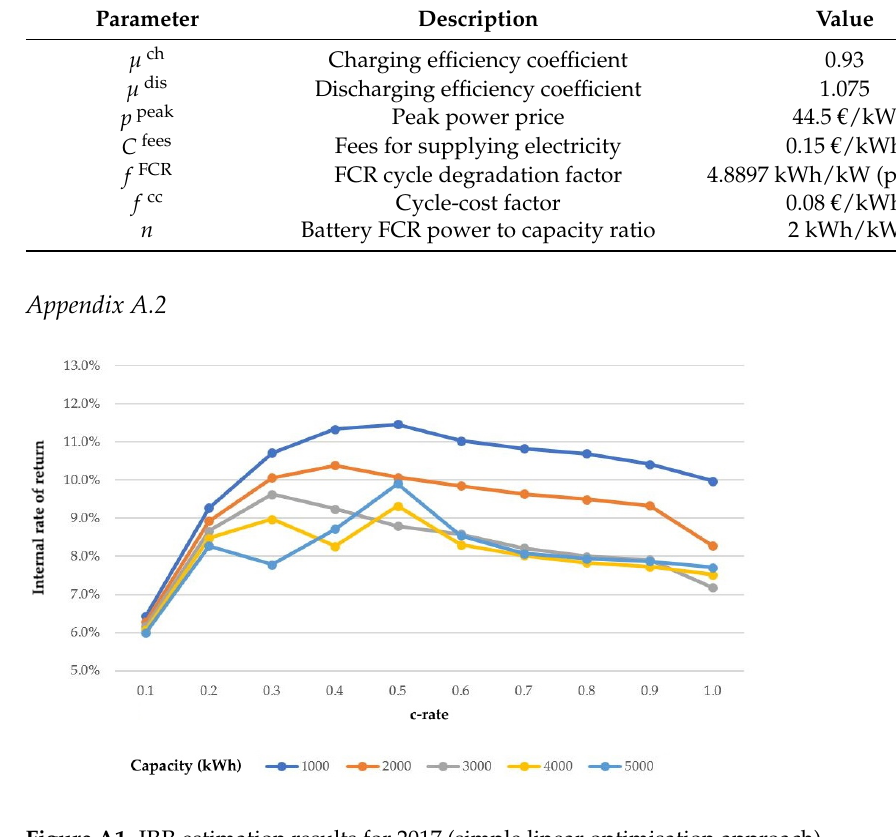
Figure A1. IRR estimation results for 2017 (simple linear optimisation approach).